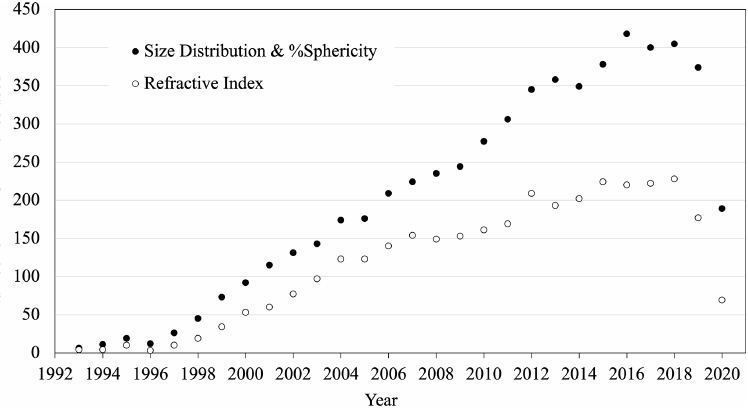
Figure 3. Number of AERONET sites selected for this study over the years. The size distribution and the refractive index are Level 2.0, while the sphericity is Level 1.5 (see text). The decrease in 2020 is because all data have yet to be validated.